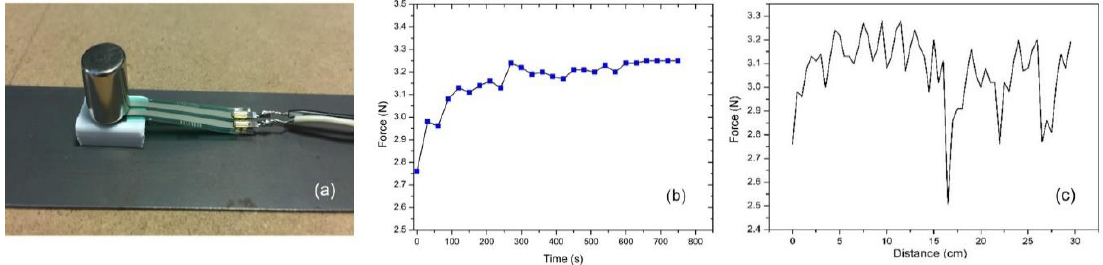
Figure 3. The FSR sensor used as a permeability sensor: ( a ) the sensor arrangement, where the FSR is between the permanent magnet and the under-test steel; ( b ) the time response of the FSR sensor; ( c ) indicative surface scanning of a non-oriented electric steel.